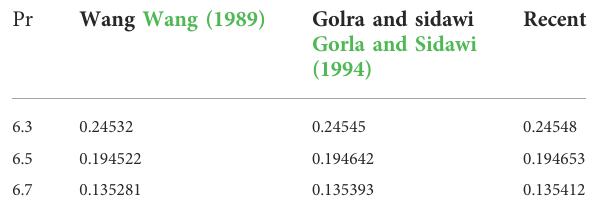
TABLE 4 Quantitative analogy with [39], [40] using Nu x Re − 0 . 5 x